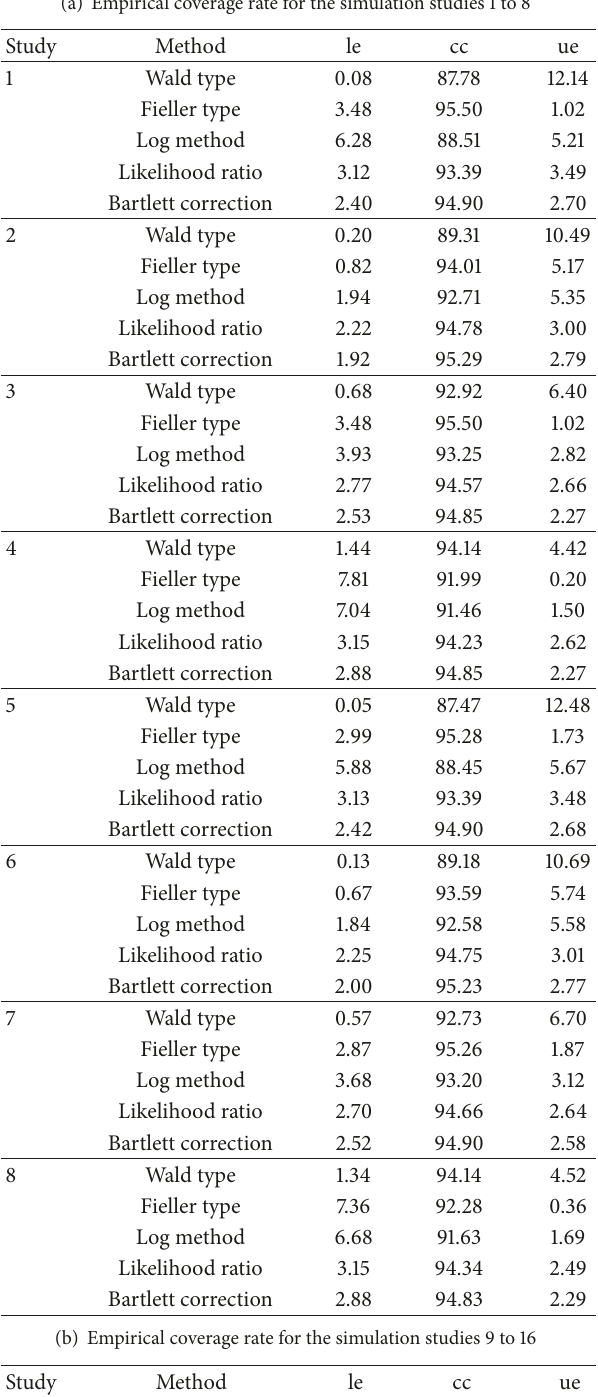
(a) Empirical coverage rate for the simulation studies 1 to